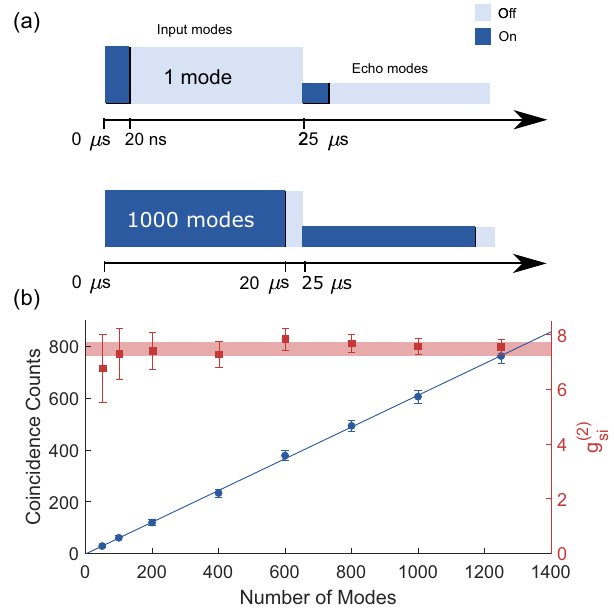
Fig. 4 | Temporal multimode capacity. a Concept of the temporal multimode capacity analysis. The storage time is set to 1/ Δ =25 μ s, with each mode having a durationof T m =20ns. b Totalnumberofcoincidencedetections(bluecircles)and second-order cross-correlation (red squares), as a function of the number of ana- lyzed modes. The g ð 2 Þ si value is calculated by integrating over the entire mode T m , which reduces it to about half of the peak value reported in Fig. 2 for 25 μ